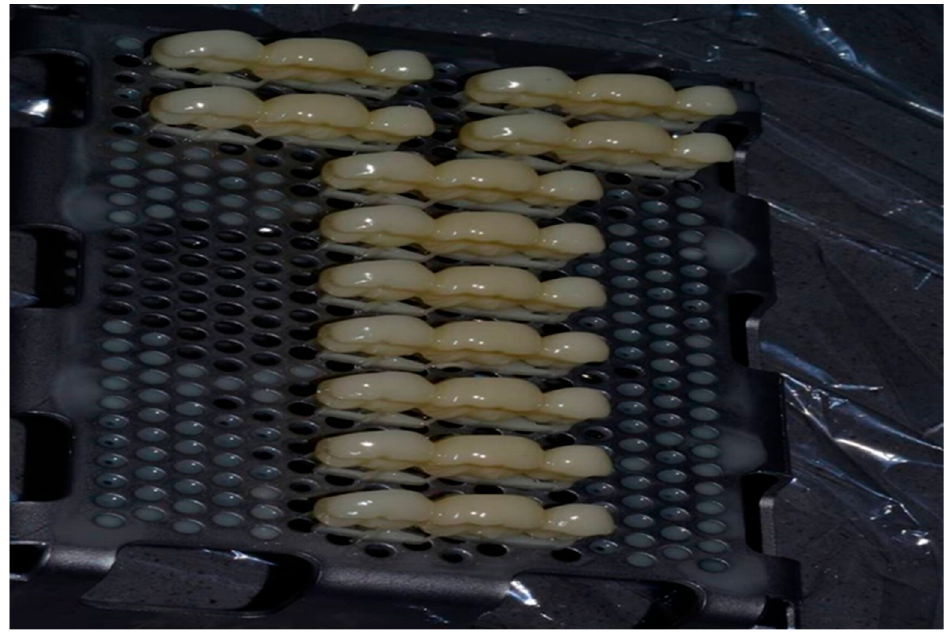
Figure 2 . Printing orientation of IFDP (90°). Figure 2. Printing orientation of IFDP (90 ◦